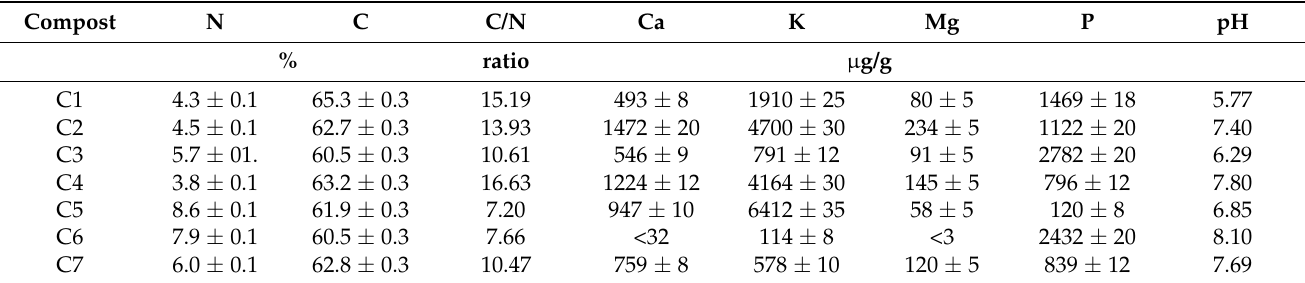
Table 2. Elemental composition and pH of the composts. Mean ± standard deviation (SD) of triplicate measurements compared using ANOVA with post-hoc Tukey’s HSD test.